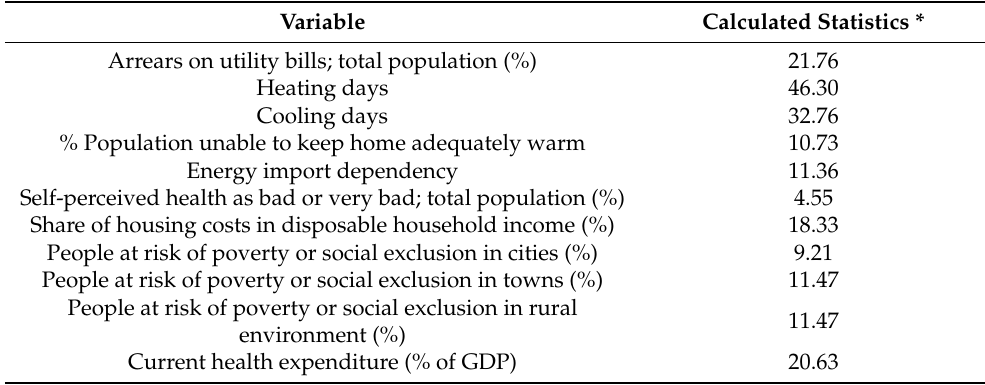
Table 2. The results of CD Pesaran’s test.